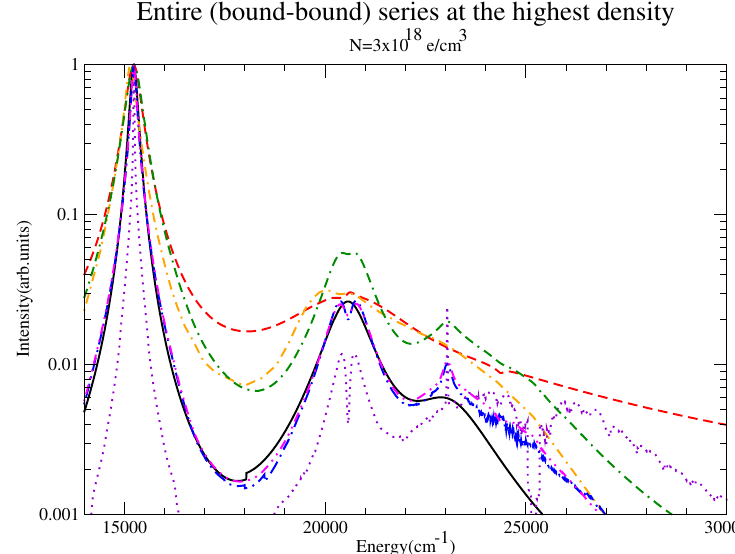
Figure 18. The entire series at the highest density. Shown are QC-FFM (solid), PPP (dashed), DWE (dash-dotted), CONVST without strong collisions (dotted), CONVST with strong collisions (dot-double dashed), CONVPST without strong collisions (long dash-dotted) and CONVPST with strong collisions (dash-double dotted).